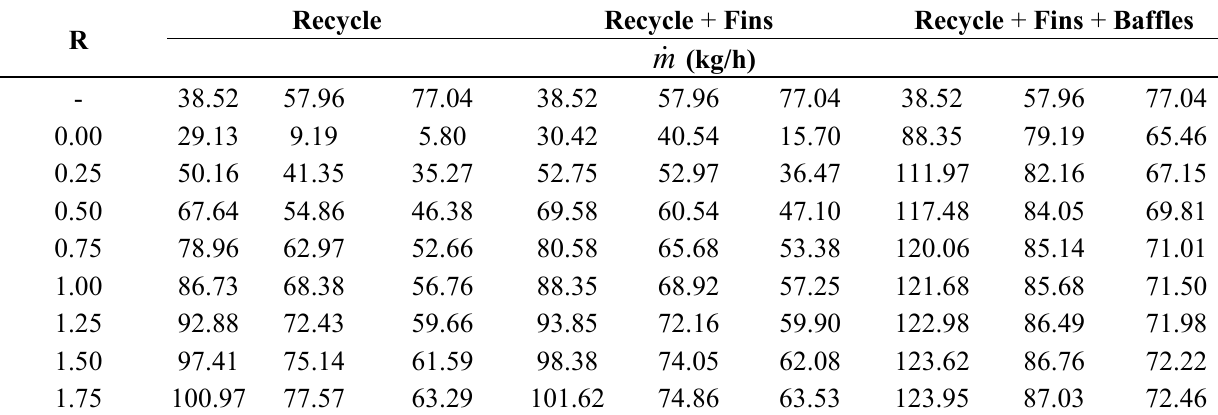
for I = 830 W/m 2 . D 0